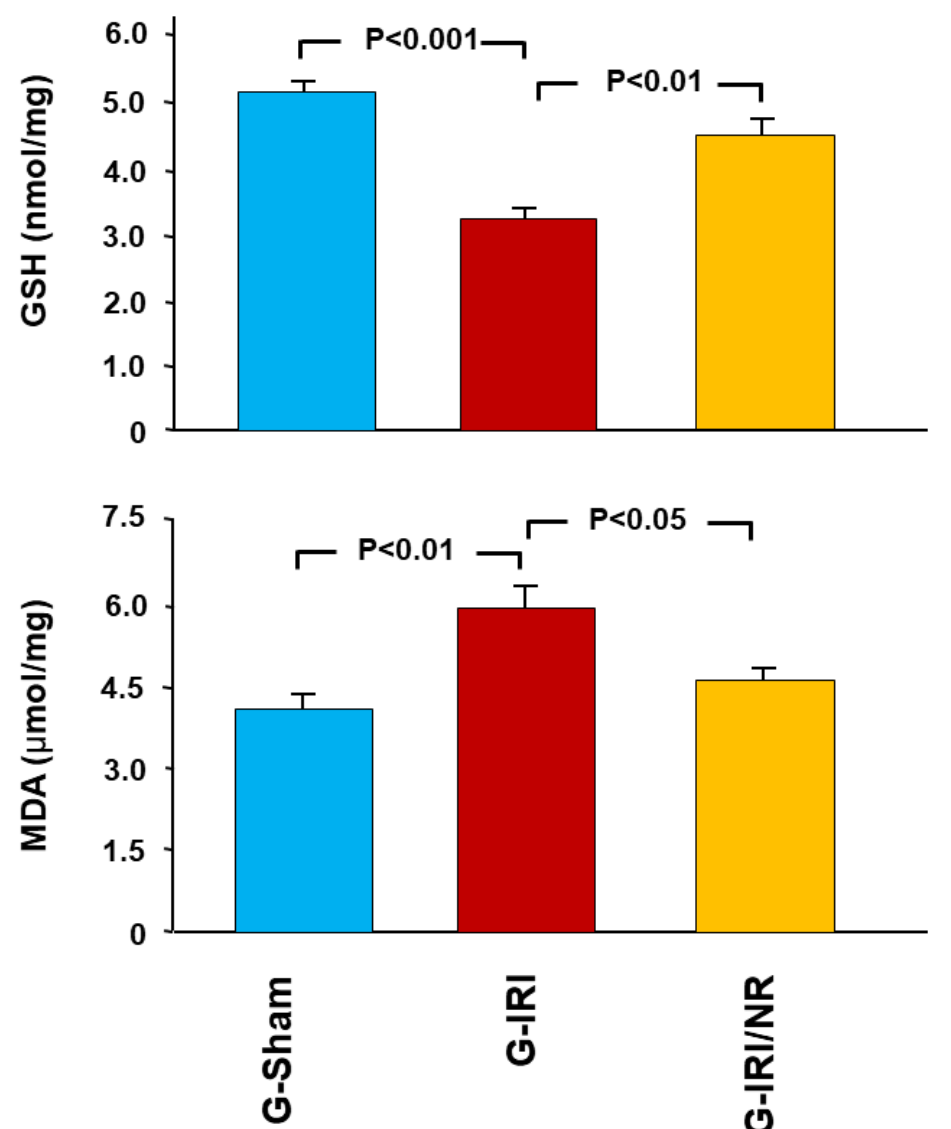
Figure 7. Kidney tissue concentration of gene expression of the glutathione (GSH) and malondialdehyde (MDA, TBARS) measured by ELISA. Values represent mean ± SEM.